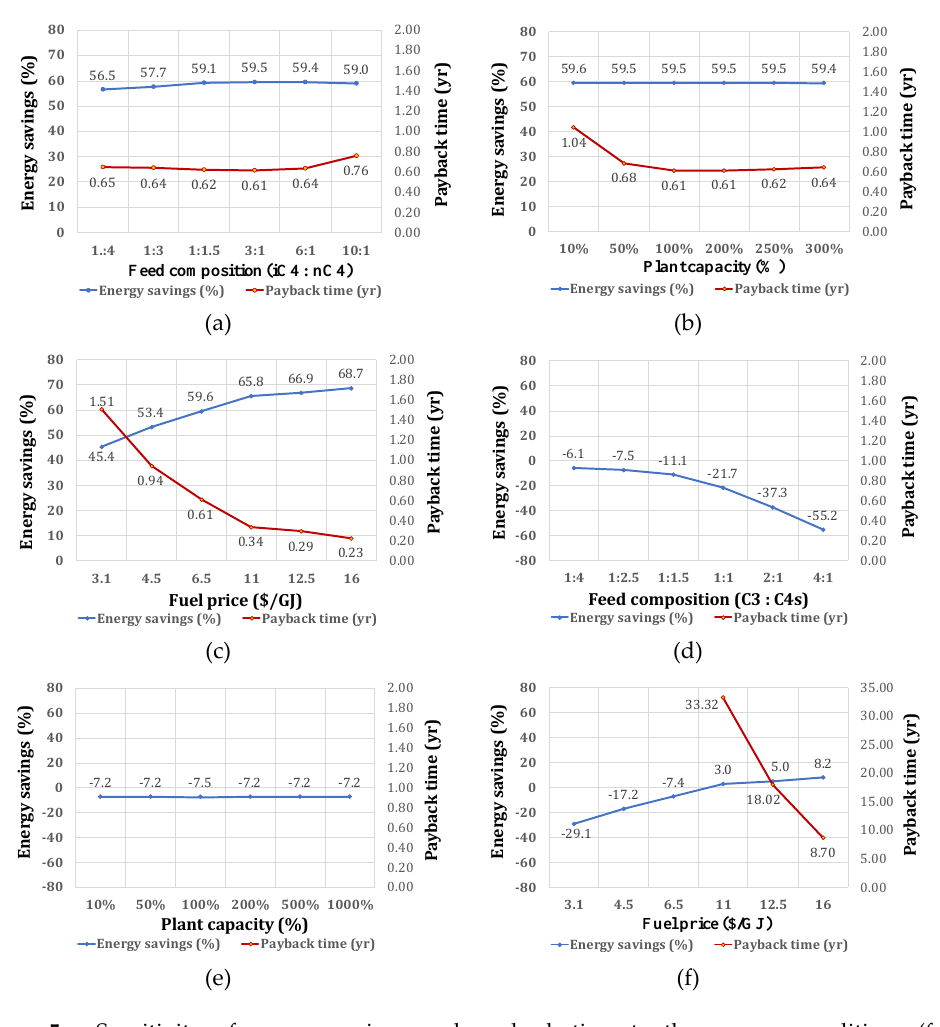
Figure 5. Sensitivity of energy savings and payback time to the process conditions (feed composition, plant capacity, and fuel price): ( a – c ) Heat pump-assisted C4 splitter; and ( d – f ) heat pump-assisted